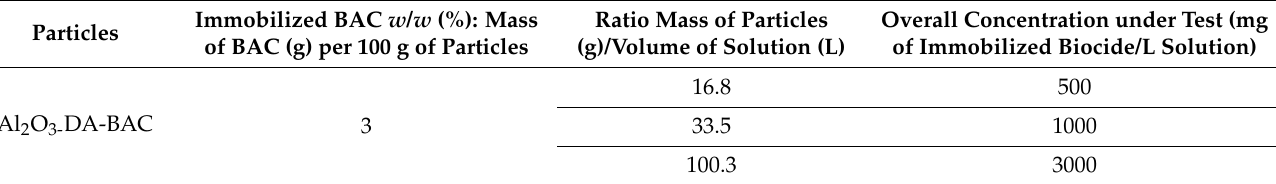
Table 3. Tested conditions regarding the overall immobilized biocide concentration. Immobilized BAC w / w (%): Mass Ratio Mass of Particles Overall Concentration under Test (mg Particles of BAC (g) per 100 g of Particles (g)/Volume of Solution (L) of Immobilized Biocide/L Solution) Al 2 O 3- DA-BAC 3